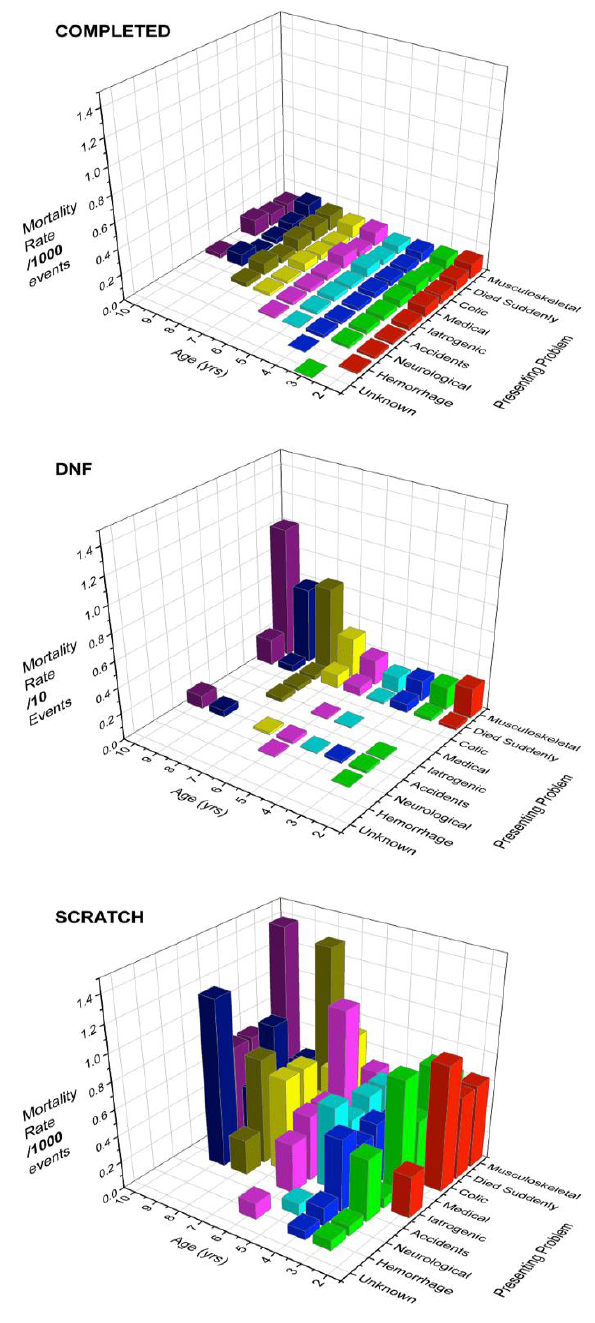
Figure 1. Mortality rates/1000 work-events (Note: /10 work-events for outcome DNF) for standard- bred horses racing in the Province of Ontario from 2003–2015. Data are drawn from the Ontario Death Registry, unit of interest work-event. ( n = COMPLETED 1,706,499, SCRATCH 65,105, DNF 6726). Rates are stratified by race outcome, AGE, and presenting problem, showing raw data rates without any adjustment for the influence of other factors. Results for ages above 10 years are not presented because group sizes were small and rates erratic. The problem category “unknown” reflects a single horse with no available data. Rates are low for COMPLETED outcomes but rise for SCRATCH outcomes and are highest for DNF outcomes. Note also that distribution of presenting problems is broad for COMPLETED and SCRATCH outcomes, but for DNF outcomes, musculoskeletal injury is by far the most frequent problem regardless of age, with dying suddenly and accidents being the next most frequent problems. Data for this Figure are presented in Table